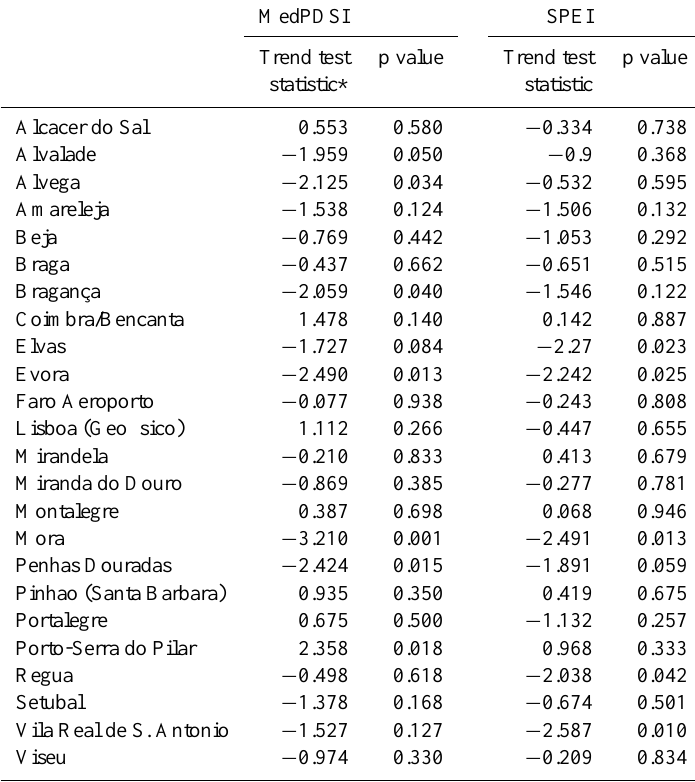
Table 3. Results of the Mann-Kendall trend test applied to MedPDSI and